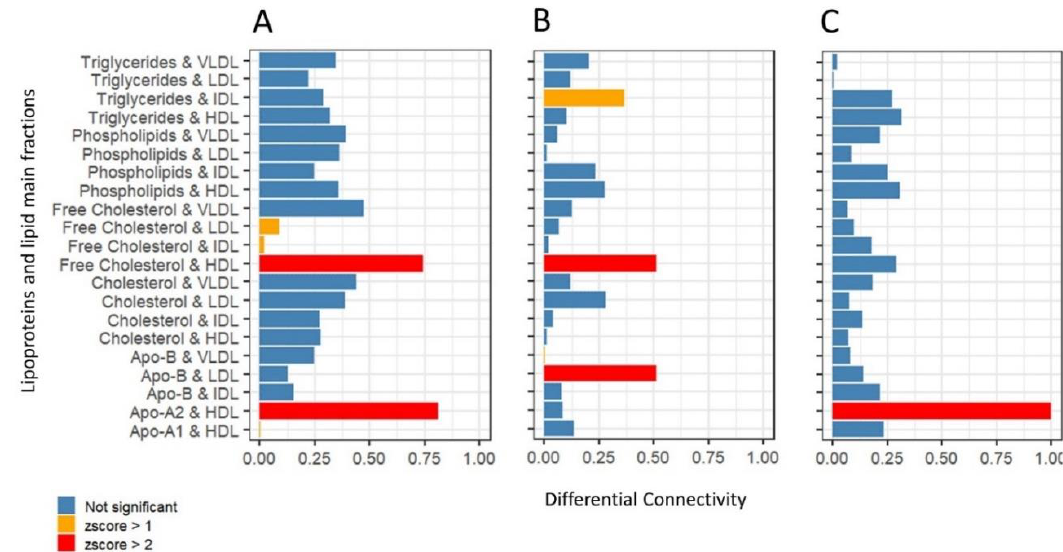
Figure 7. Differential Connectivity Analysis: comparison of node (lipoprotein) connectivity in the main lipoprotein fraction association networks of ( A ) men vs women; ( B ) young men vs old men; ( C ) young women vs old women. Differential connectivity is calculated using Equation (A5). Bars are color-coded by z -score value (Equation (5)).